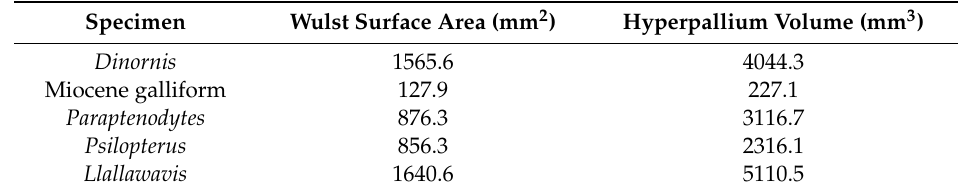
Table 2. Measured Wulst surface areas and phylogenetically predicted hyperpallium volumes for all extinct specimens in the sample with quantifiable Wulsts.